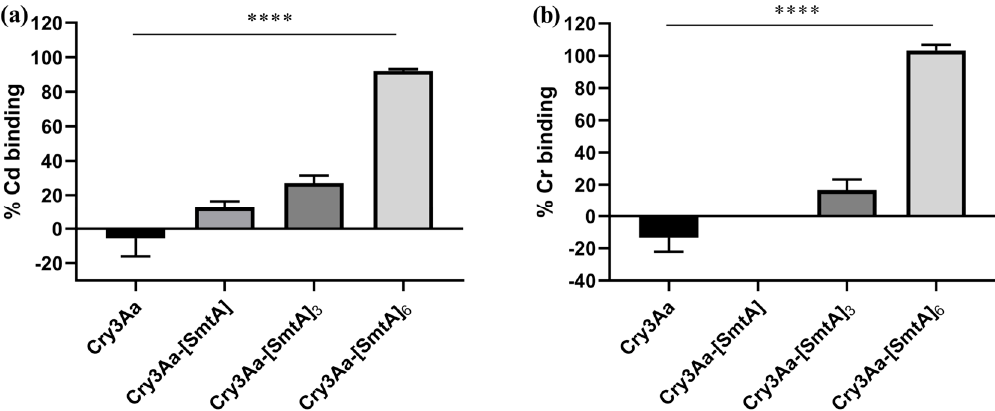
Figure 4. Atomic absorption spectrometry (AAS) analysis of the metal binding capacity of Cry3Aa (control) and Cry3Aa-SmtA fusion crystals. Percentage of ( a ) Cd 2 + and ( b ) Cr 3 + ions bound to crystals. All measurements were performed in triplicate. The error bars show the standard deviation of the mean. Repeated measurements of Cry3Aa-[SmtA] showed no binding of Cr 3 + ions. **** p < 0.0001 by one-way ANOVA.